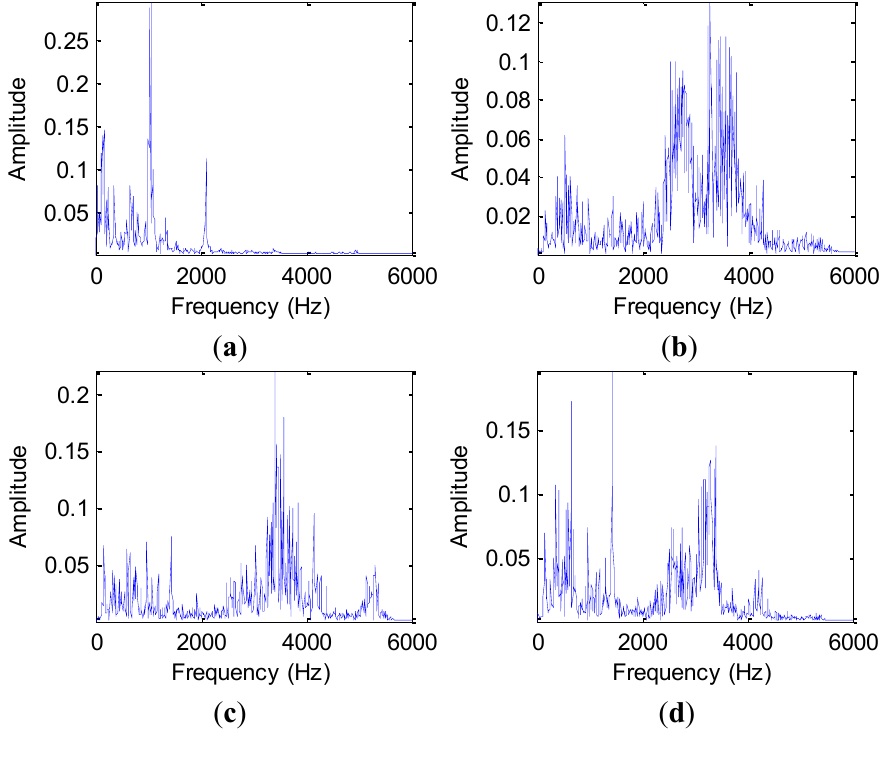
Figure 7. The single-sided amplitude spectrum based on FFT in the D_MIX dataset: ( a ) the normal bearing. ( b ) IRF14 bearing. ( c ) ORF14 bearing. ( d ) BF14